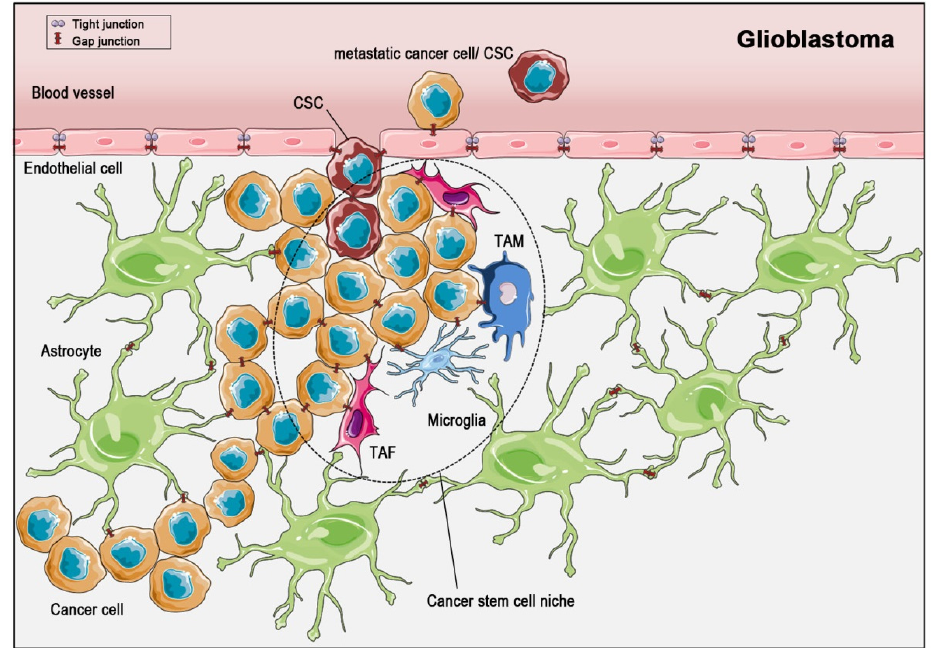
Figure 3. The microenvironment of the glioblastoma stem cell niche. In glioma, cancer stem cells (CSCs) are embedded in a surrounding consisting of tumor-associated macrophages (TAMs), tumor-associated fibroblasts (TAFs), and microglia. Cell-cell communication through gap junctions (red symbols) is known to exist within the astrocytic syncytium, within cancer cell and within CSC populations, as well as between astrocytes and cancer cells, between cancer cells and endothelial cells and between cells of the CSC niche and cancer cells. During metastasis, CSCs and cancer cells develop gap junctions to communicate with endothelial cells, which are normally sealed with tight junctions. Finally, they enter the blood circulatory system for